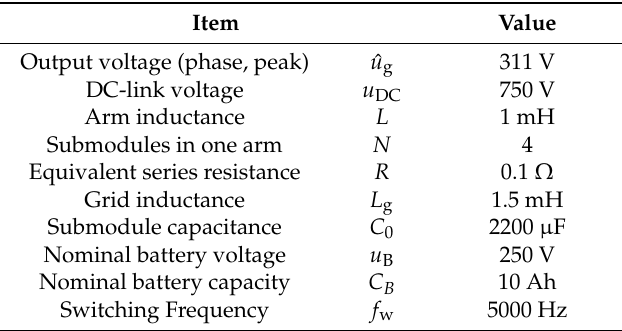
Table 1. The parameters of the simulation system.